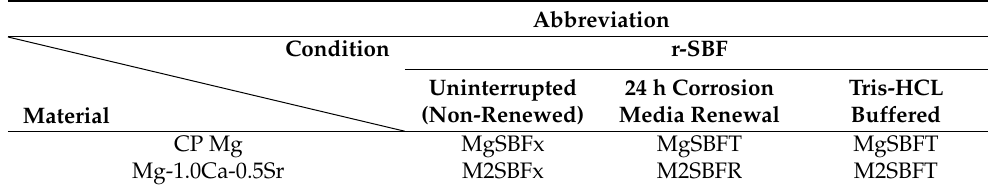
Figure 1. Schematic representation of the experimental setup for the immersion test. The sample was suspended using inert fishing line during the immersion period, with the evolved H 2 gas being calculated based on the displaced r-SBF in the burette. Table 1. Designated abbreviations for CP Mg and Mg-1.0Ca-0.5Sr alloy in three different pH-regulating treatments in r-SBF.